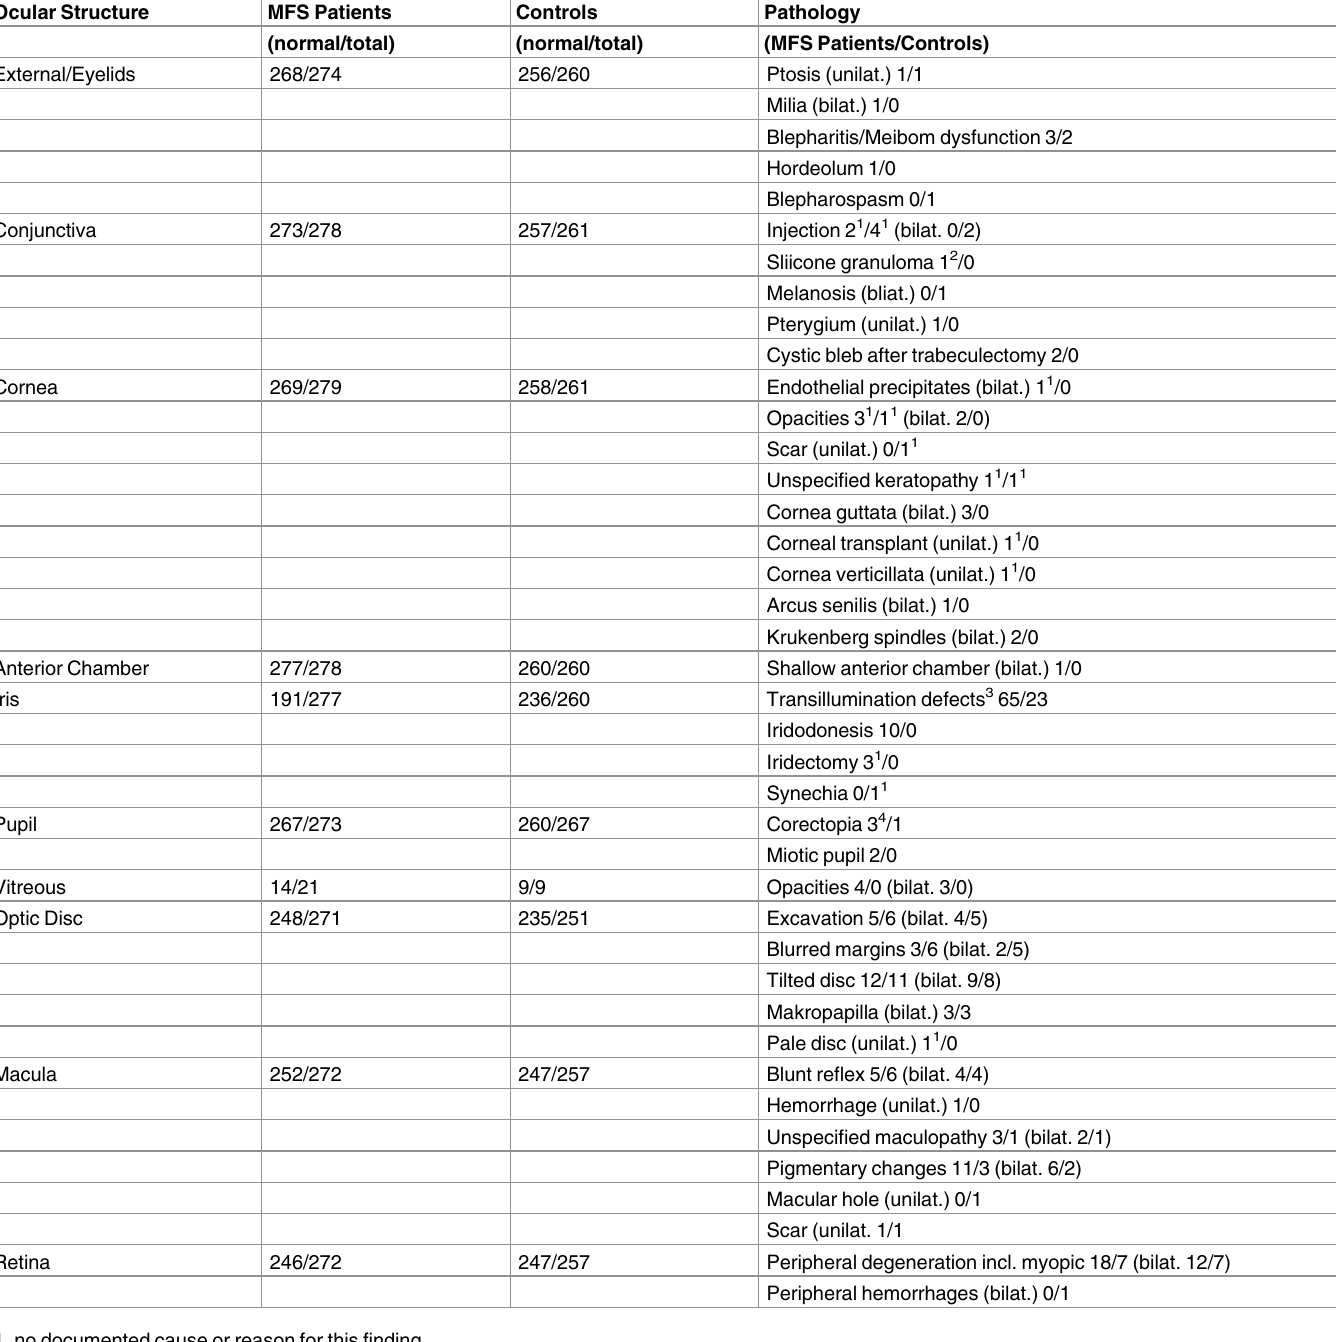
Table 3. Structural ocular findings in patients with Marfan syndrome (MFS) and controls. Total = number of patients with documentedfindingsfor the respectivecategory, unilat. = unilateral,bilat. =